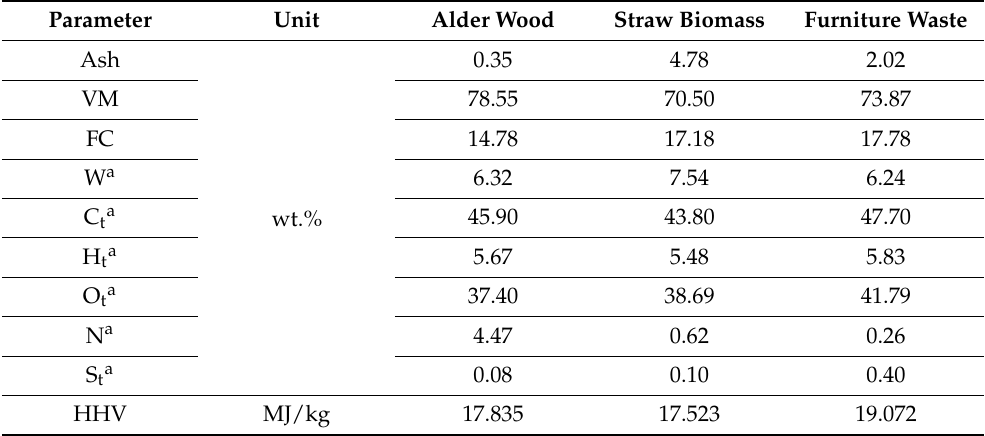
Table 2. Basic physical and chemical characterisation of applied biomass-based materials [37], reproduced with permission from